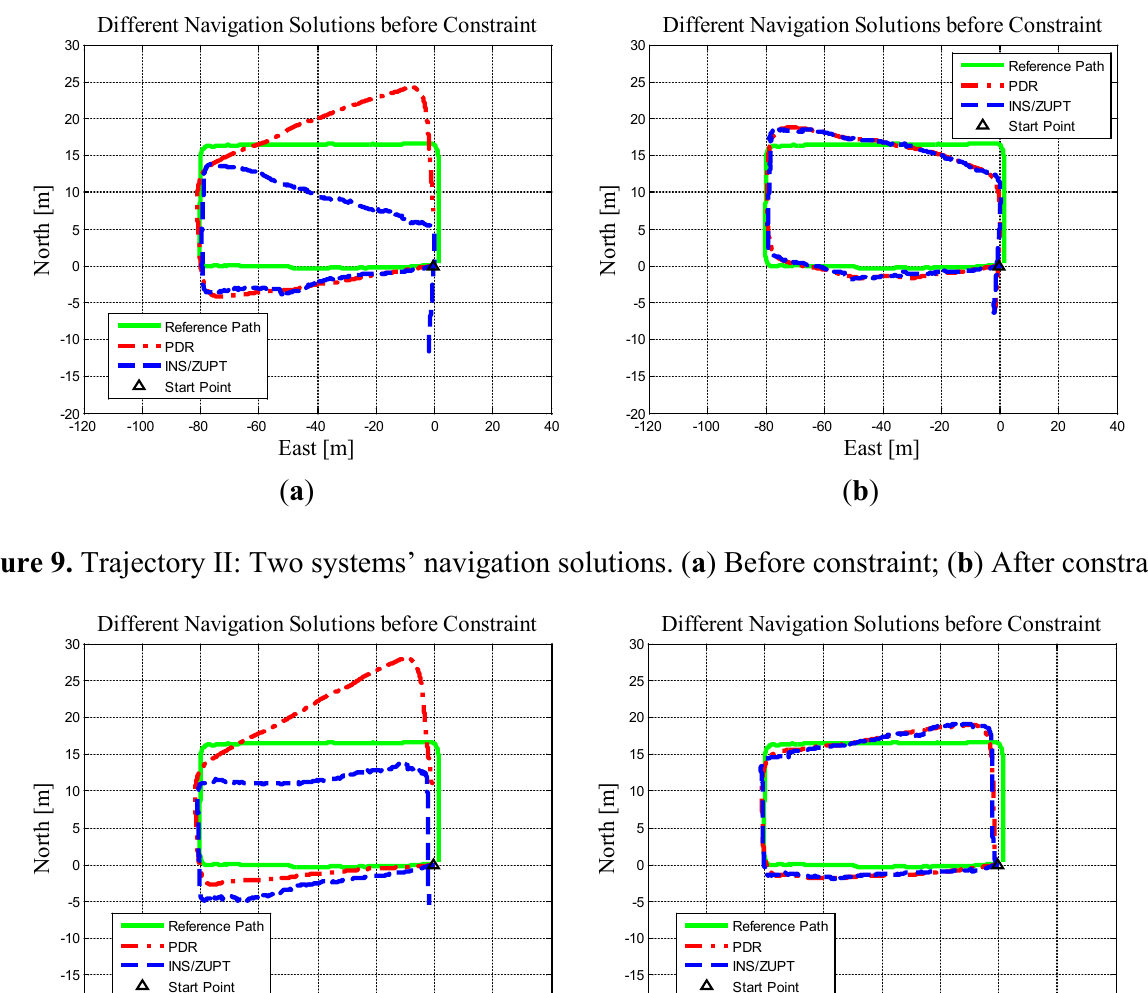
Figure 8. Trajectory I: Two systems’ navigation solutions. ( a ) Before constraint; ( b ) After constraint.